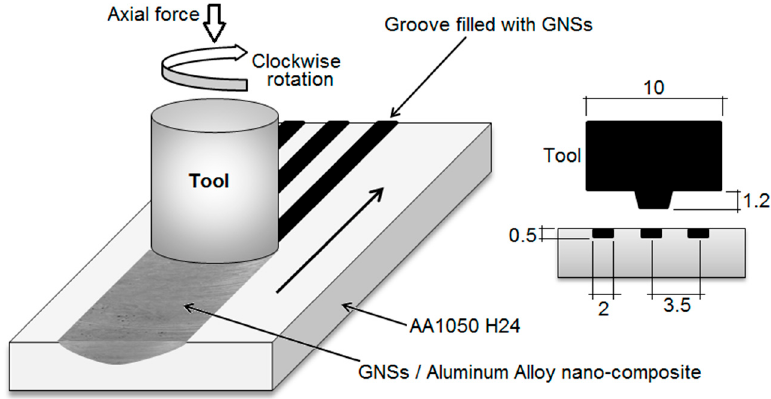
Figure 1. Schematics of the FSP process to manufacture GNS/AA1050